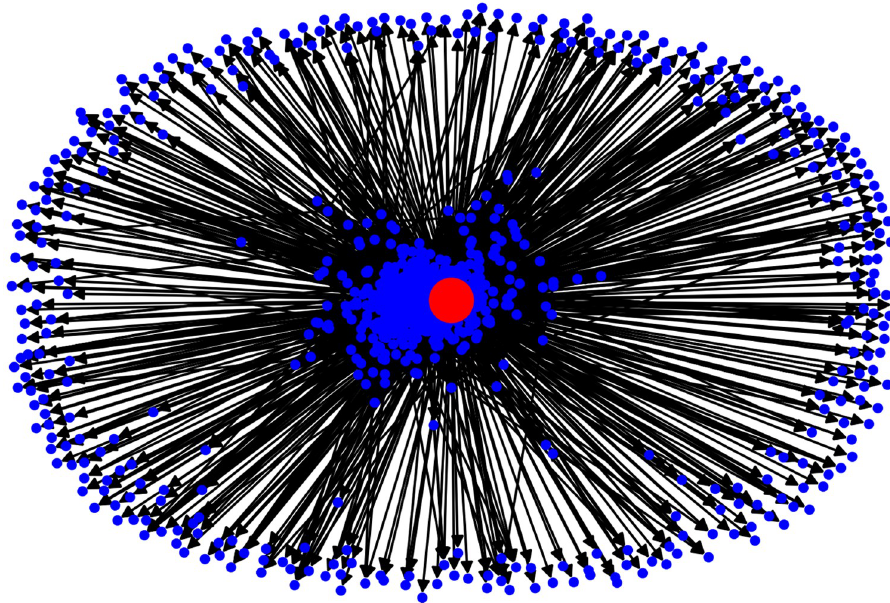
Fig 7. Citation network for topmost applicant ‘Siemens AG’ (best viewed in color).